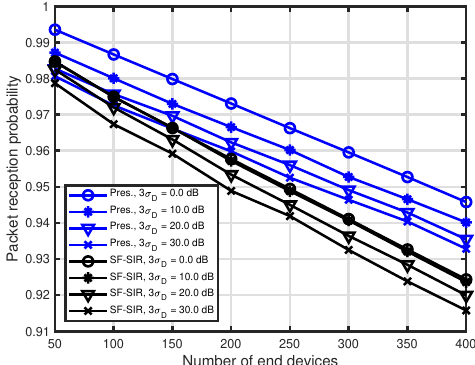
Figure 6. Performance comparison when the quality of the communication link is changed. R = 6000m, = 1.5 I = 0dB, 5dB, 10dB, W mAh, 3 σ C MIN D